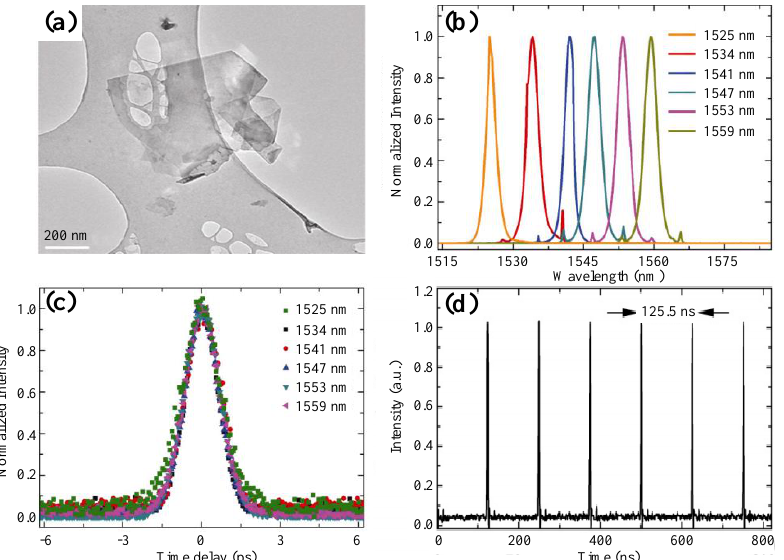
Figure 8. The experimental results of mode-locked EDFL enabled by graphene SA. ( a ) TEM image of a folded graphene flake. ( b ) Output spectra. ( c ) Autocorrelation traces. ( d ) Output pulse train. ( a – d ) adaped from